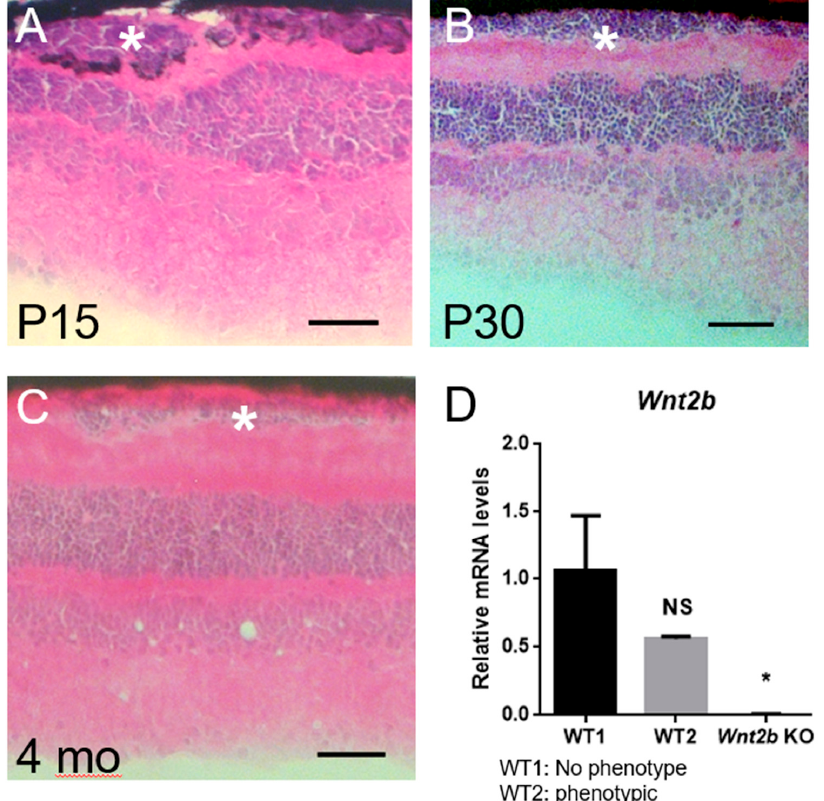
Figure 6. WT eyes occasionally show phenotype of ectopic photoreceptors, indicating the possi- bility of altered Wnt2b expression or unknown alternative genes involved. ( A – C ) H&E staining on WT retinal cross sections at P15 ( A ), P30 ( B ), and 4 months old ( C ) showing ectopic nuclei (*). Scale bars: 50 µm. Image ( A ) also shows ectopic pigments, consistent with pigment observation in KO samples at P15 (shown in Figure 4B,C). ( D ) qPCR of Wnt2b mRNA expression in WT1 (without phenotype), WT2 (with phenotype), and KO mouse eyes from age-matched adult mice (4 months old). Lack of Wnt2b expression is confirmed in KO, and the phenotypic WT2 mouse shows lower yet statistically insignificant levels of Wnt2b compared with WT1 without phenotype. Each sample con- tains a half eye cup with retinas after lens removal, with histological analysis of phenotype